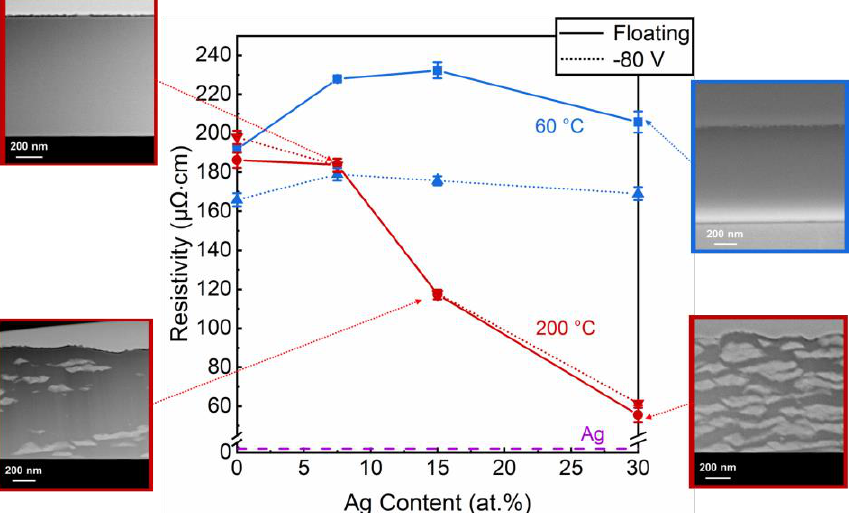
Figure 6. ( a ) Elemental reconstruction of Zr, Cu, Al, and Ni positions, and ( b ) concentration profile of the cylindrical region indicated in ( a ), of the pure TFMG, deposited without bias at 60 ◦ C. ( c ) Recon- struction of Zr, Cu, Al, Ni, and Ag positions, and ( d ) concentration profile of the cylindrical region indicated in ( c ), of the TFMG containing 30 at.% Ag, deposited without bias at 60 ◦ C.